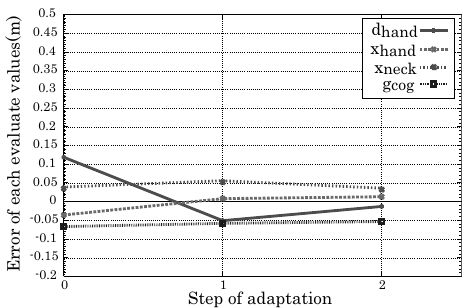
Figure 15 Transitions of evaluation values (over-hand brachiation).